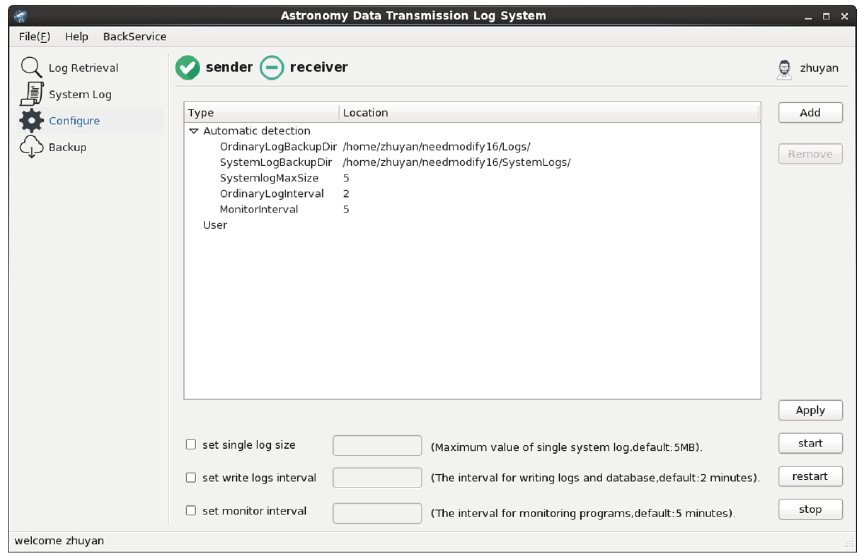
Figure 8: Control interface.